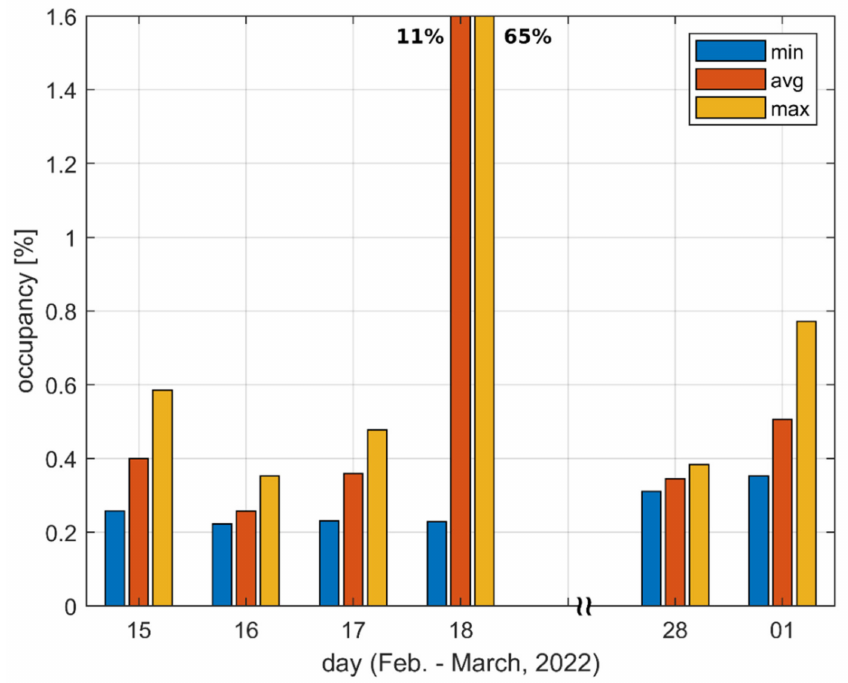
Figure 6. Minimum, average and maximum observed channel occupancy values for Location